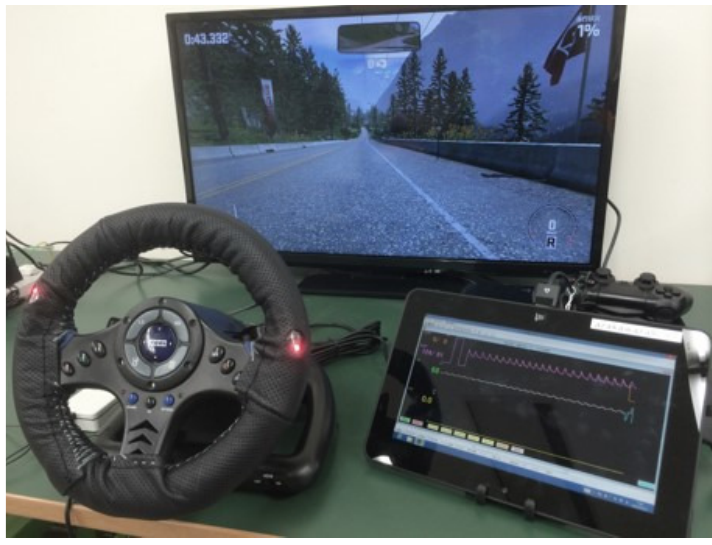
Figure 6. Appearance of the developed system and tablet